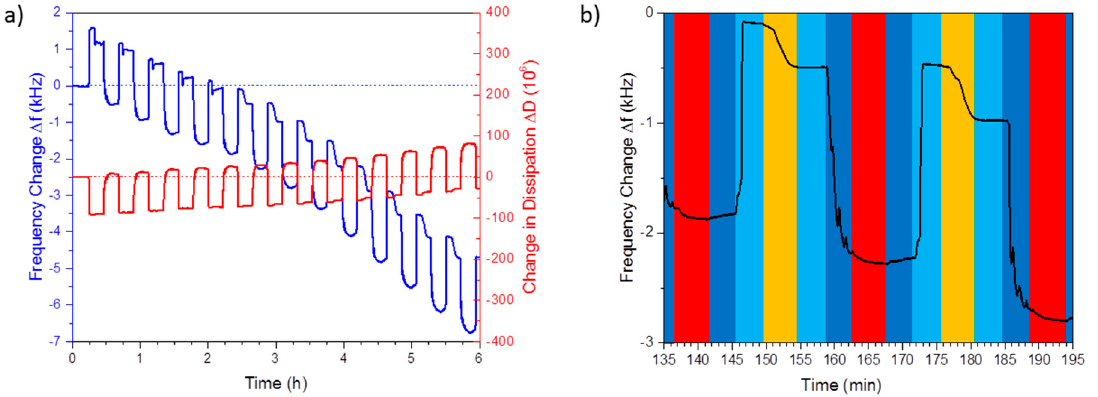
Figure 2. ( a ) Frequency change and change of dissipation during the automated layer-by-layer self-assembly process indicating multilayer formation; ( b ) detailed information of the 6th and 7th cycle (color code of the flowing solutions is the same as in Figure